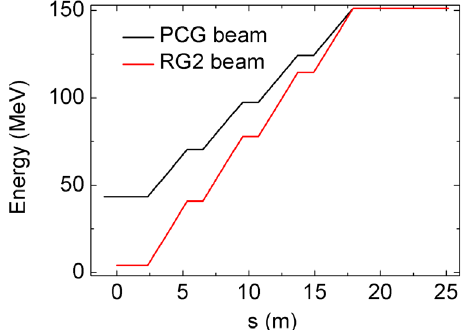
FIG. 2. Lattice functions of spectrometer beam line and straight beam line in LEA for round beam.